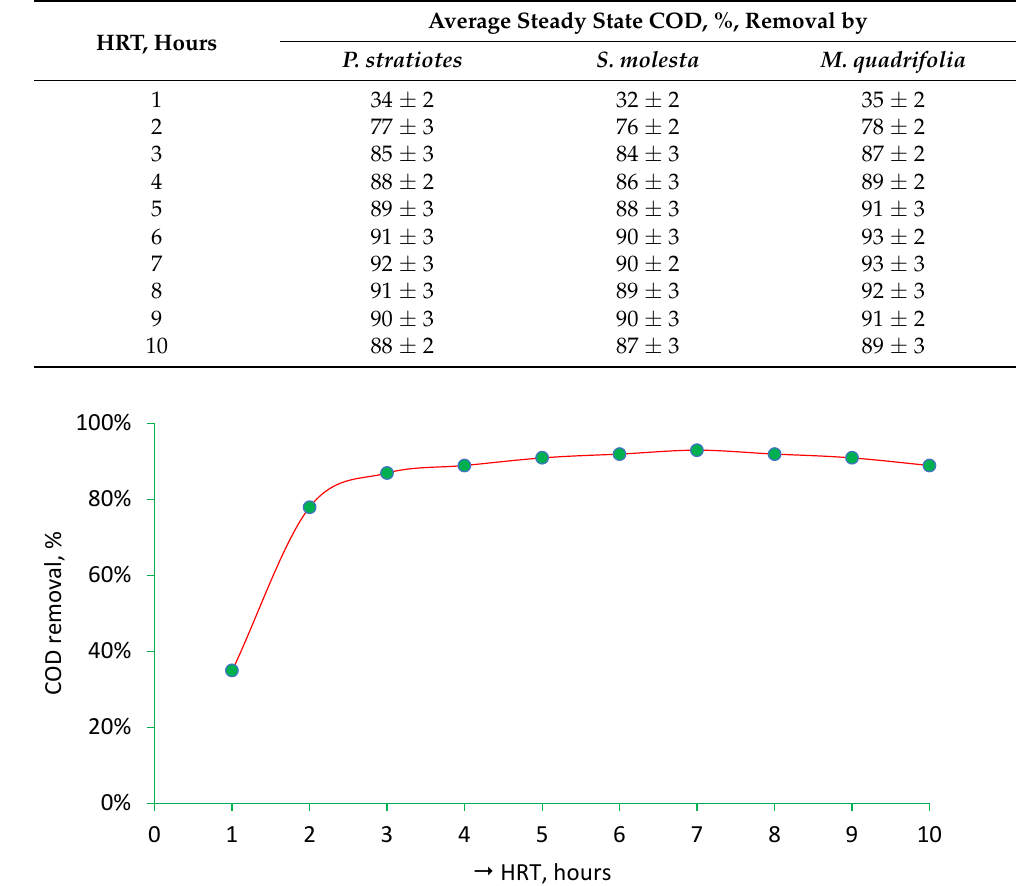
Table 4. Average removal of different constituents at of each constituent steady state by the three macrophytes at the HRT of 2 h, and the maximum concentration recorded in the effluent. Average Removal, %, by Constituent